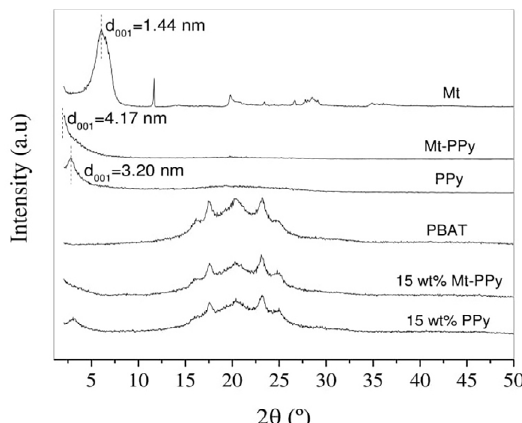
Figure 4. X-ray diffraction spectra of Mt, conductive additives (PPy and Mt-PPy) and PBAT composites with 15 wt% of Mt-PPy and 15 wt% of PPy.